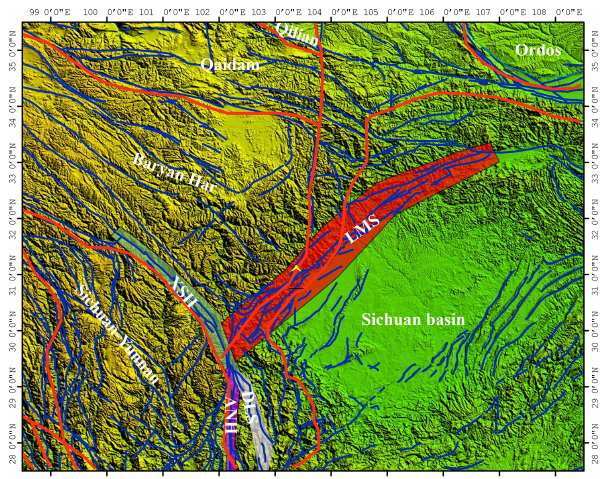
Figure 1. Map of the active faults and the location of the Wenchuan earthquake. LMS denotes the Longmenshan fault zone; XSH de- notes the Xianshuihe fault zone; DLS denotes the Daliangshan fault zone; ANH denotes the Anninghe fault